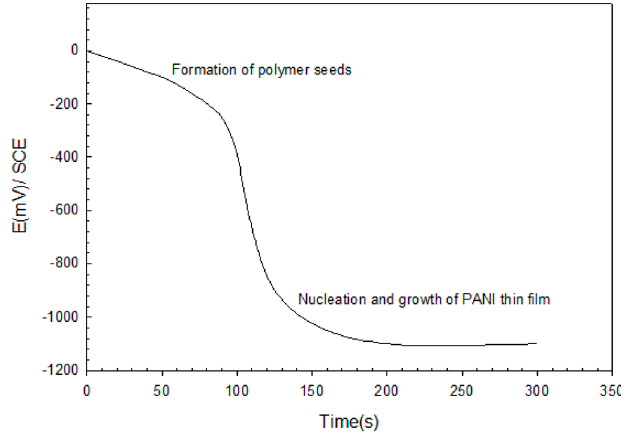
Figure 4. Galvanostatic deposition of PANI thin film.